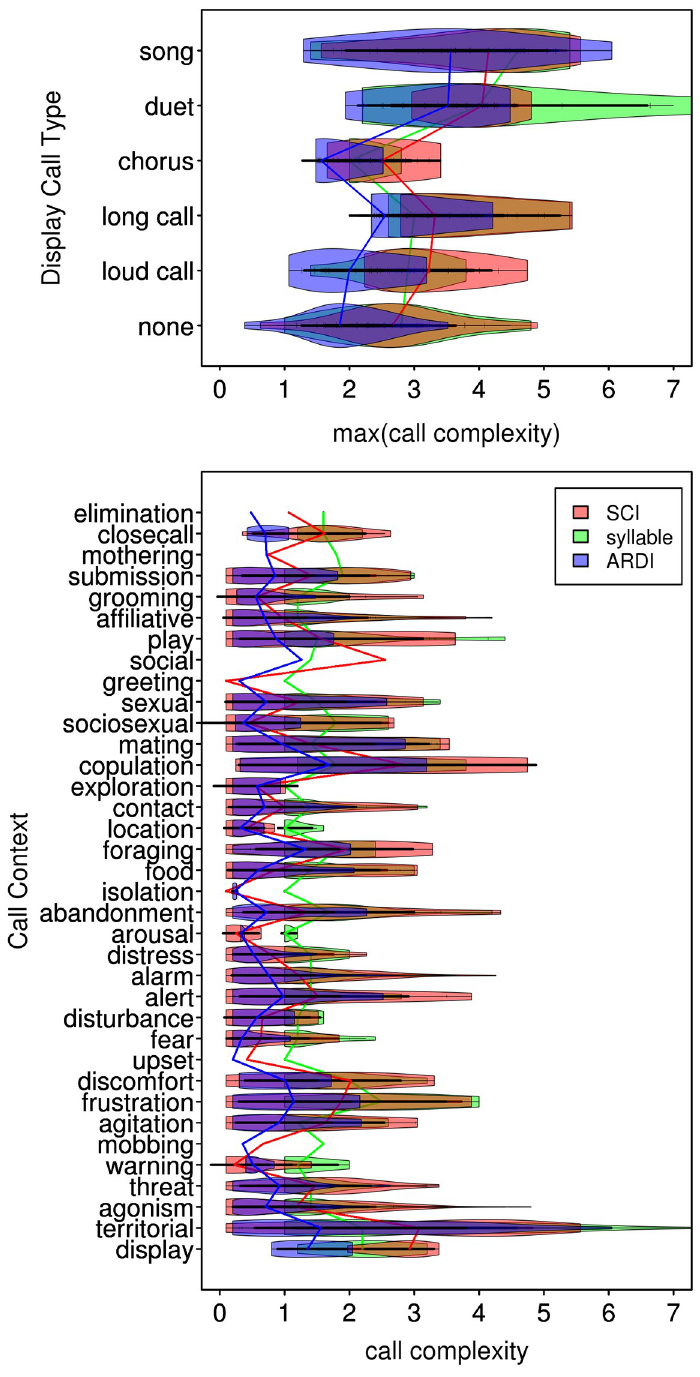
Fig 7. Corroborative violin plots of complexity scores versus call types and contexts. a. High correspondence with “duet” and “song” is seen for all complexity metrics. SCI, which favors length over other features, also captured longer calls. Chorus , interestingly did not correlate highly under any metric. ARDI scores were relatively lower for calls in the non-display types than SCI and syllable, potentially reflecting a robust specificity. b. Outwardly focused social, display, and territorial calls are the primary vocalization context that appear to strongly associate with higher call complexity values. The relatively higher ARDI scores for foraging and exploration contexts provide support for identity and location-based signaling [126] as part of AAH. The lower scoring sociosexual (versus actual copulation) contexts lend less support for evolution by sexual courtship mechanisms of musical evolution. ARDI most strongly rivals SCI in several contexts—such as grooming, mothering, isolation, greeting, location, and exploration—suggesting that